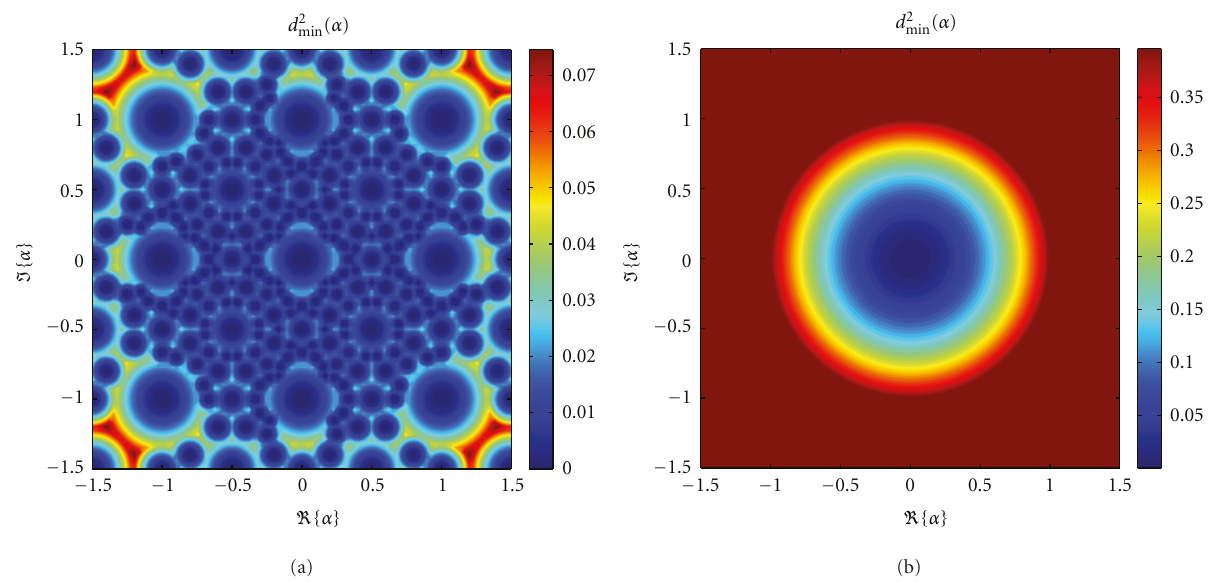
Figure 10: Hierarchical minimum distance performance for 16-QAM and 16-ary example codebook (zero mean). the pairwise boundary invariant to channel parameter